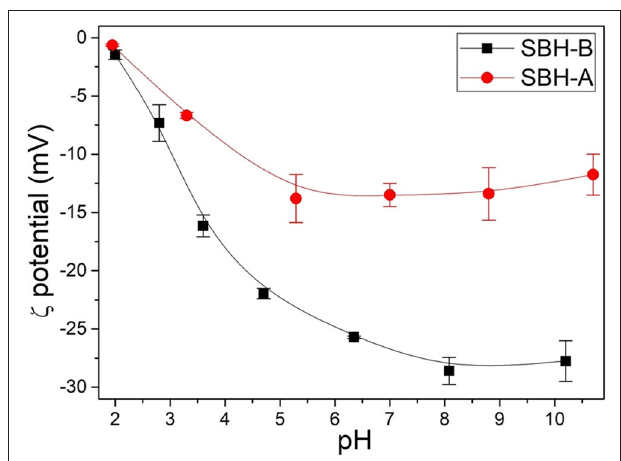
FIGURE 1 | ζ -potentials of SBH-B and SBH-A at different pH values.